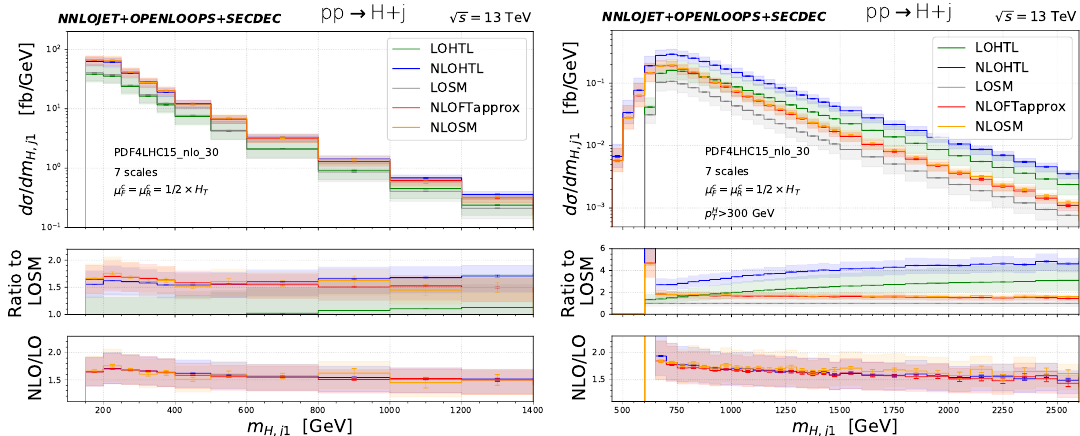
Figure 3 . Invariant mass distribution of the Higgs and the jet for inclusive H+ jet production (left) and with p T ; H > 300 GeV (right). Colour coding and labelling as in figure